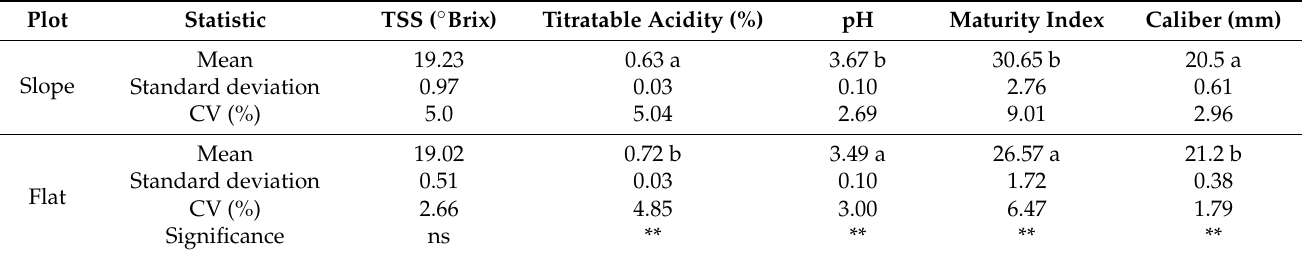
Table 3. Descriptive statistics and analysis of variance (ANOVA) for the berry physicochemical parameters of the slope and flat plots under